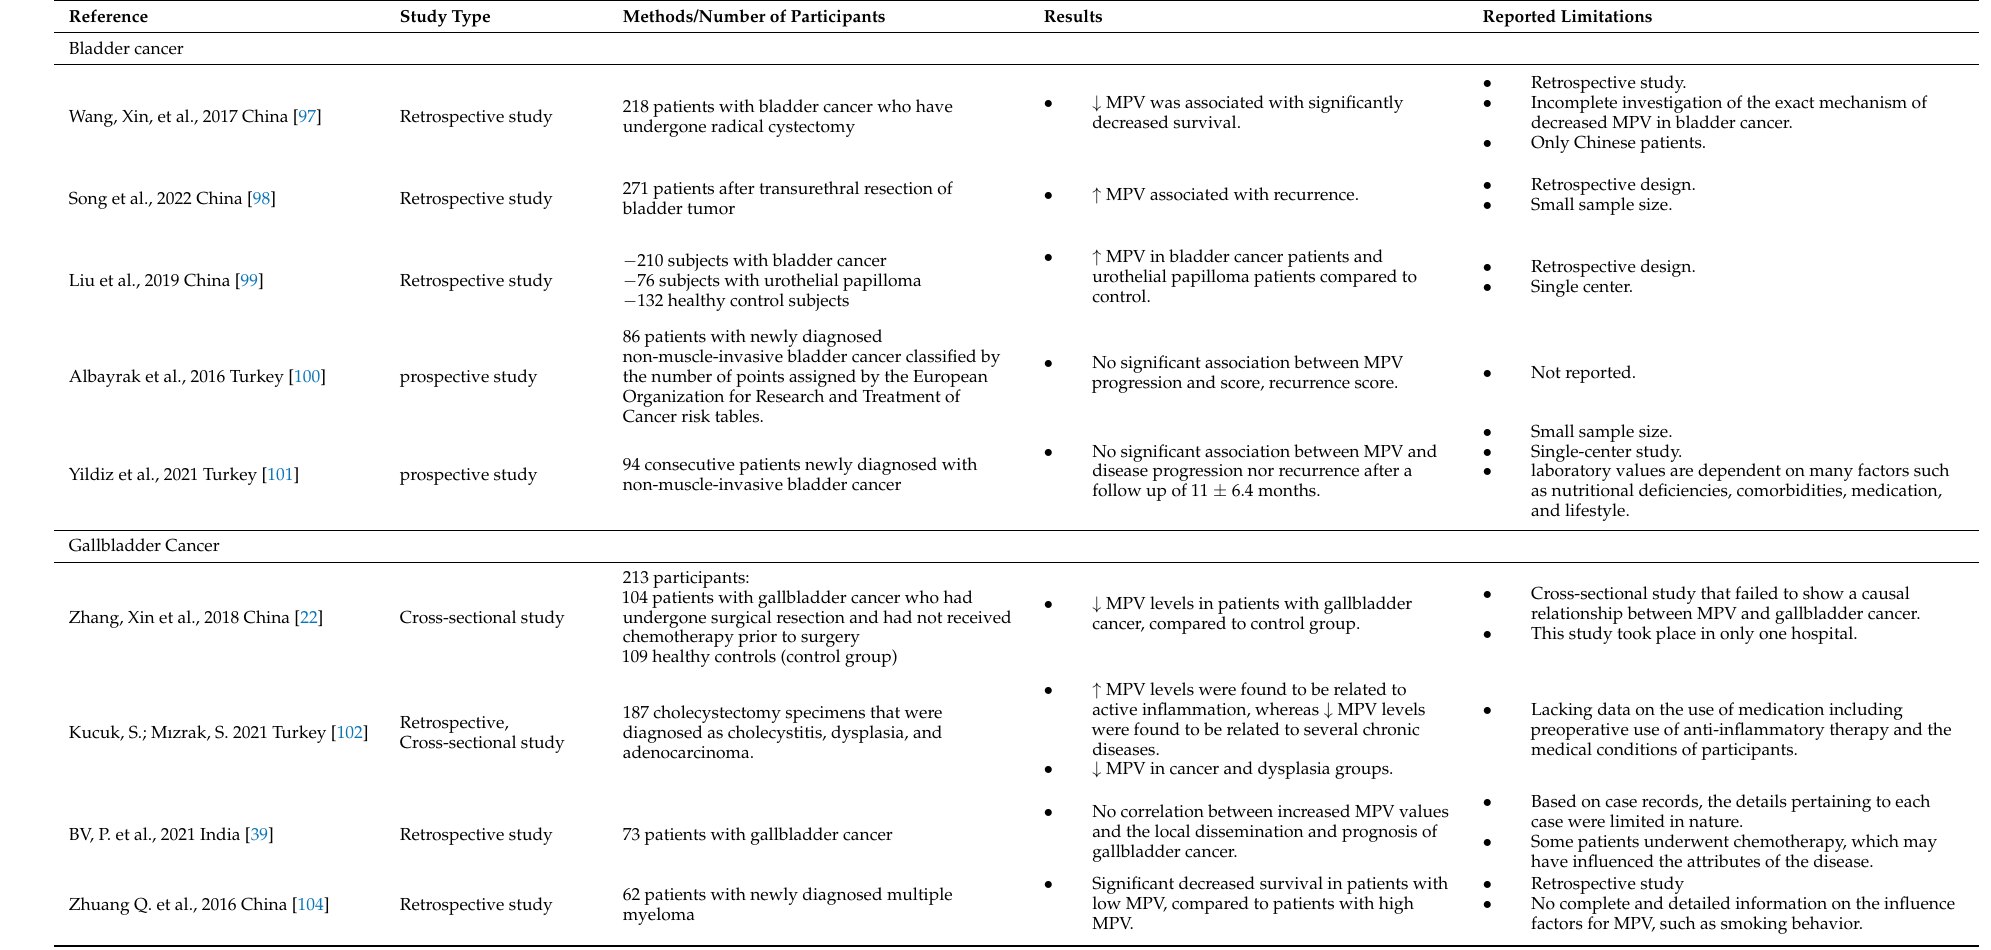
Table 7. Studies relating MPV to other types of cancer (bladder cancer, gallbladder cancer, and multiple